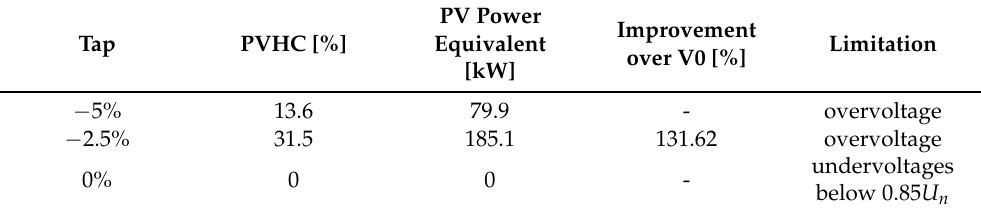
Figure 14. Box plot of voltage distribution for increasing DPI for two different tap positions of DETC TR. Table 3. PVHC results for different DETC tap position of MV/LV